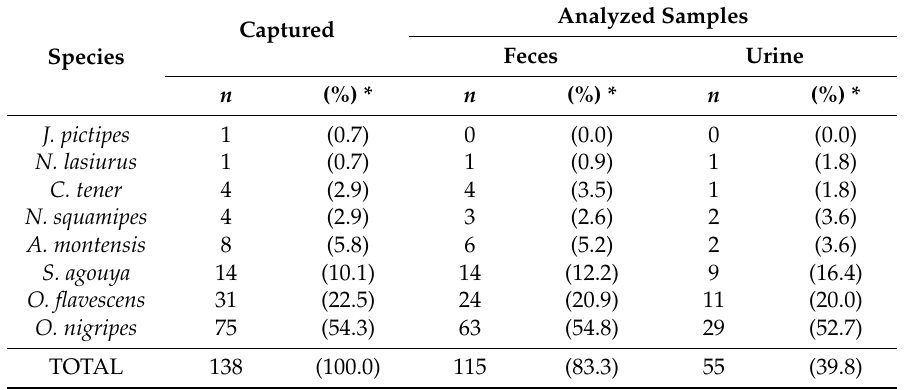
* Percentages calculated over the total numbers of samples.